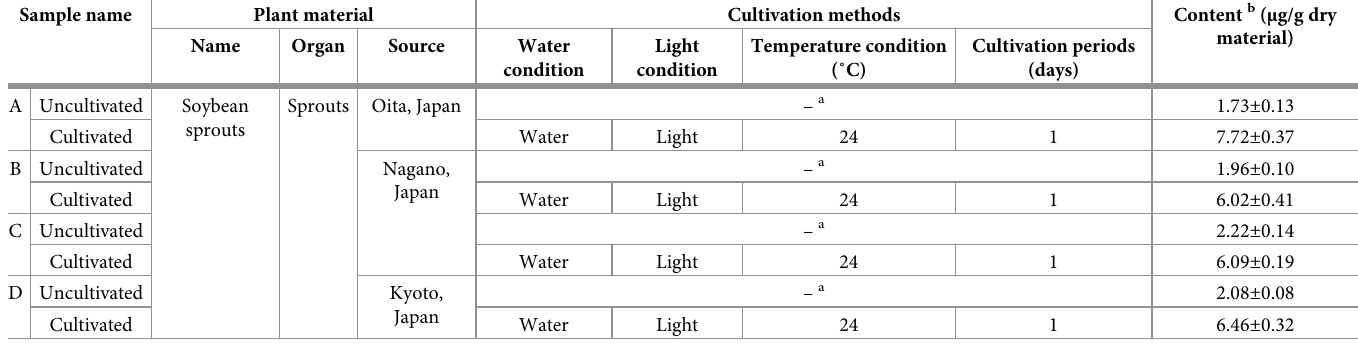
Table 3. Sample details and CM contents in various commercial soybean